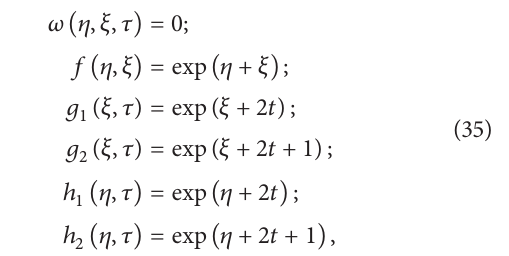
the Maclaurin approximation for the computational interval , 𝑏 ] = [0, 𝜋] , this assumption may decrease the accuracy [𝑎 𝜂 𝜂